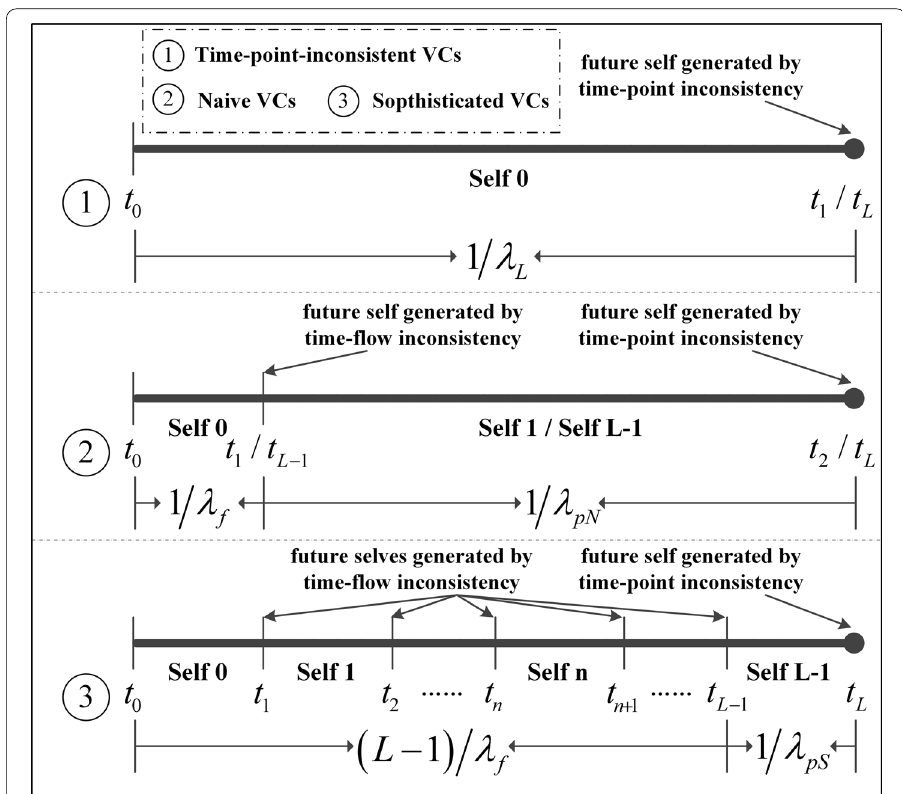
Fig. 3 The exit decision comparison of the three defined time‑inconsistent venture